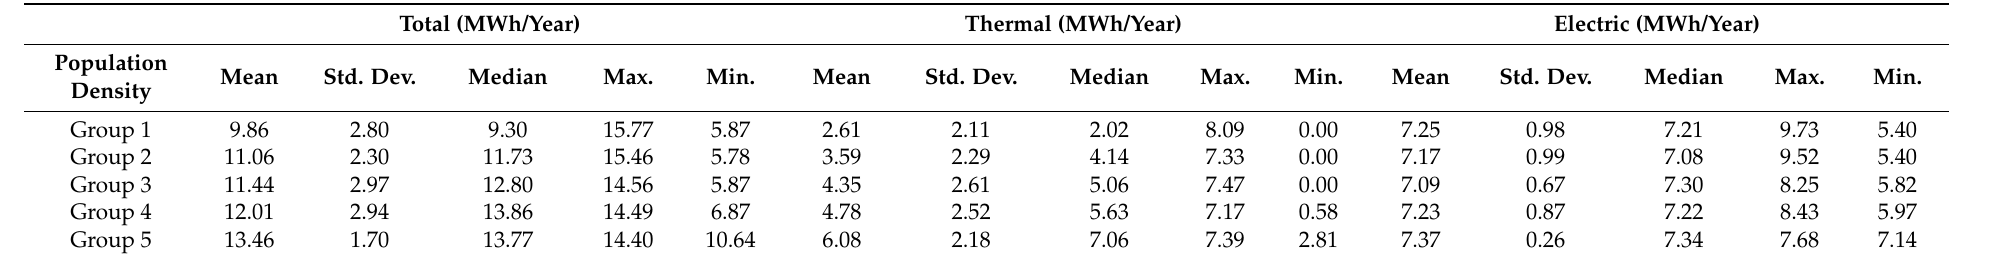
Table 3. Statistical data of energy consumptions per household by group of cities without the influence of climate. Total (MWh/Year) Thermal (MWh/Year) Electric (MWh/Year) Population Mean Std. Dev. Median Max. Min. Mean Std. Dev. Median Max. Min. Mean Std. Dev. Median Max. Density